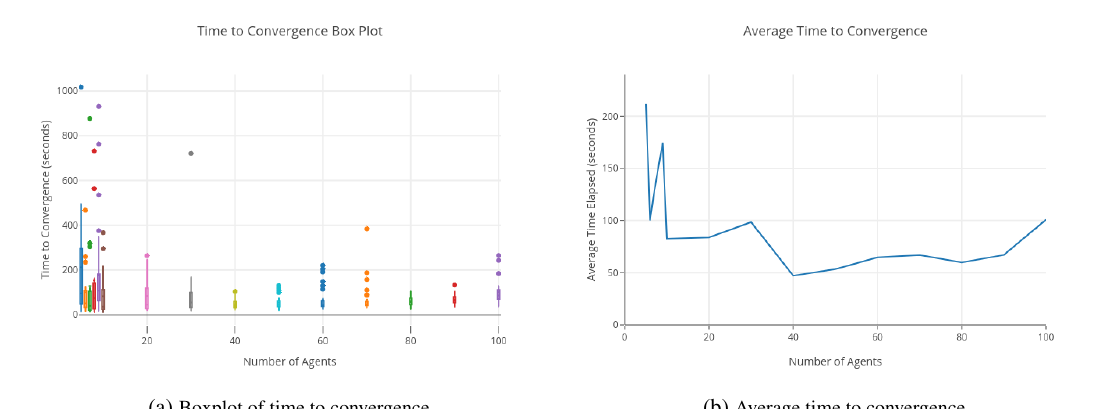
Fig. 6. These figures show the time the agents took to converge to the objective from the moment they were initialized. These results were obtained from the simulated configuration as described in the hardware section on page 48.